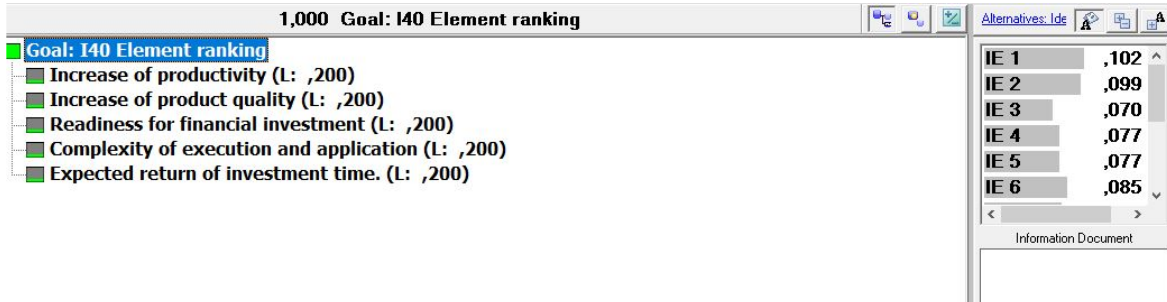
Figure 6. Goals importance definition—case study.